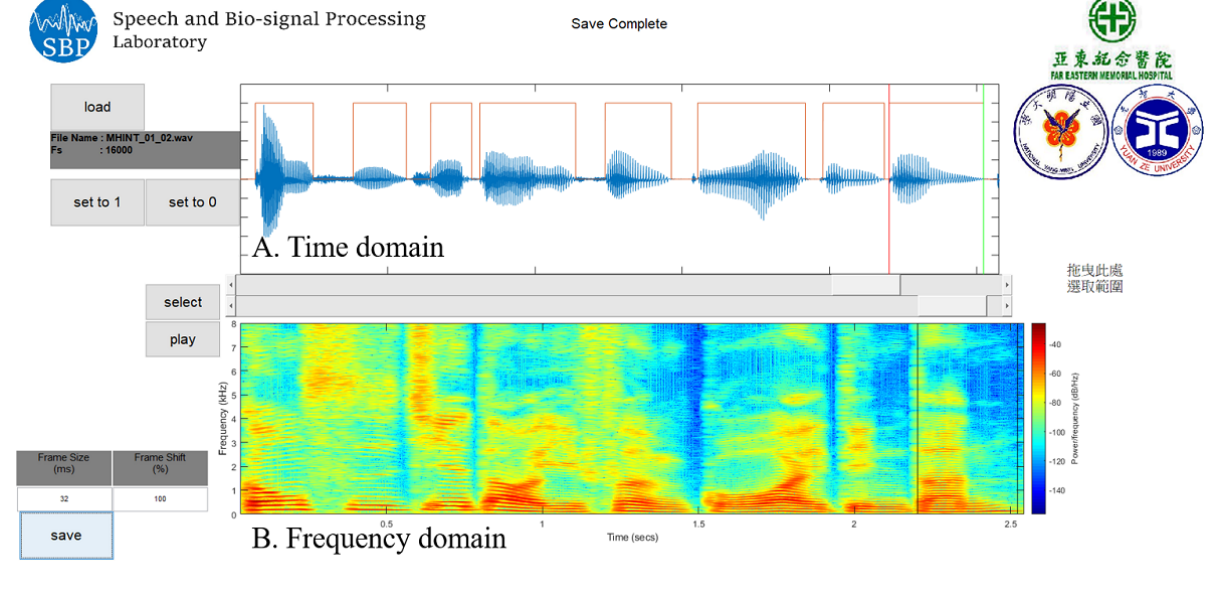
Figure 2. Overview of user interfaces in the proposed labeling tool. The selected speech segments are displayed as red